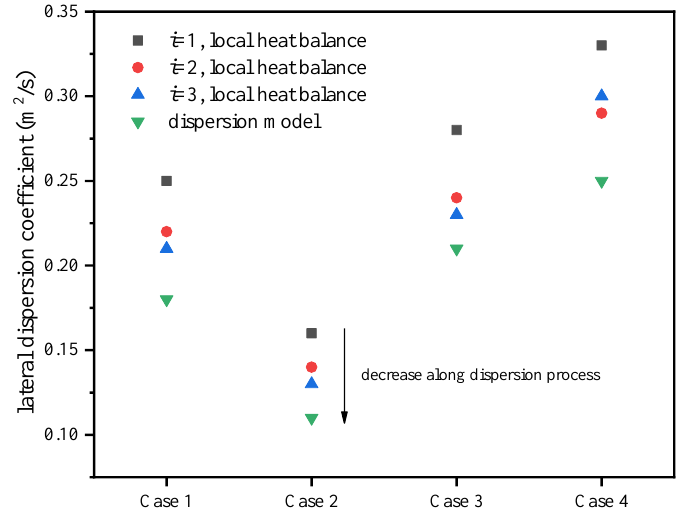
Figure 7. Comparison of lateral fuel dispersion coe ffi cients based on the dispersion model and the local heat balance method.